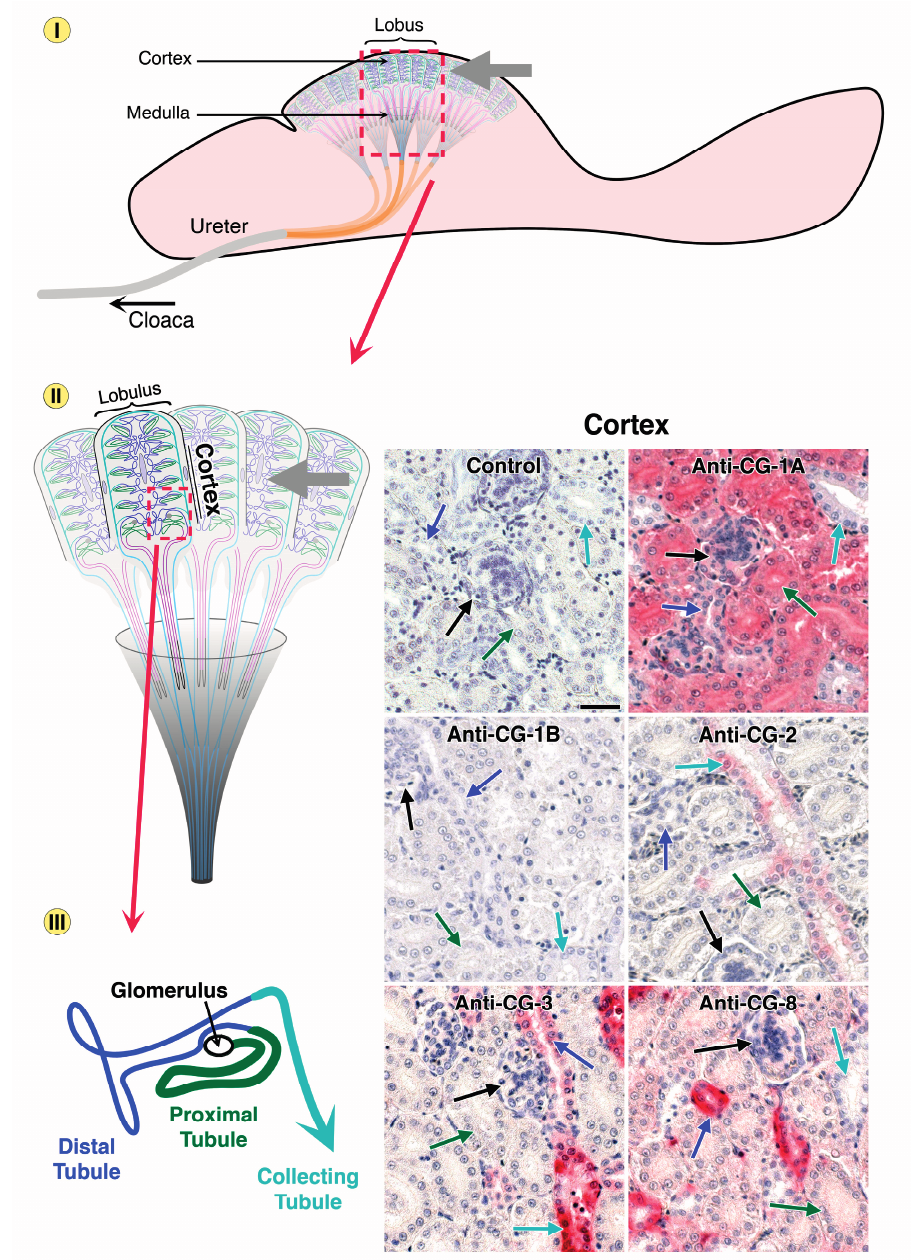
Figure 7. Schematic illustration of the chicken urinary system and its distinct regions on three levels of microscopical magnification. Starting with the lobus (dashed square, top, with the cortex region highlighted by the grey arrow), uriniferous tubules of the lobules (dashed square, middle) in the kidney cortex are organized in consecutive segments, given in different colors (bottom). Arrows in respective color point to these regions in the microphotographs of immunohistochemical galectin localization (bar = 25 µm). Control section was processed to reveal any antigen-independent staining (no incubation step with antibody in otherwise identical processing). Comparison of staining profiles discloses a qualitative difference in expression of the proteins of the paralogue pair CG-1A/B. On the cellular level, CG-2 and CG-3 were seen in cytoplasm and nuclei, CG-1A and CG-8 were confined to the